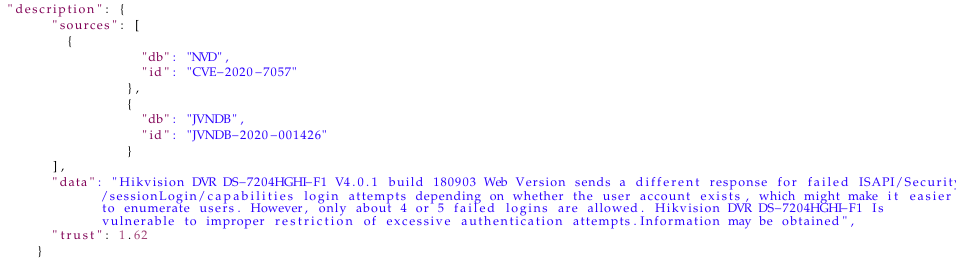
vulnerable to improper restriction of excessive authentication attempts.Information may be obtained", "trust": 1.62